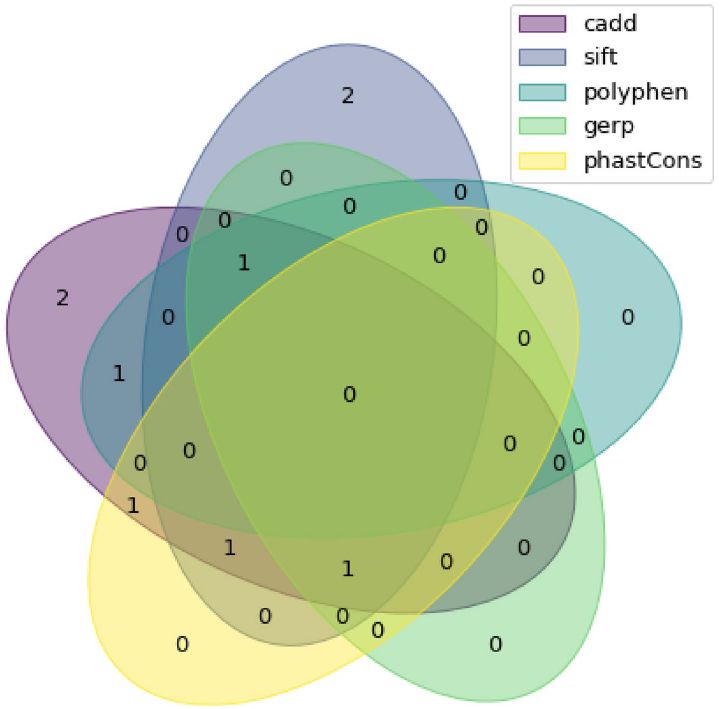
Figure 2. Venn diagram of included variants from exome-seq for each bioinformatic filter.